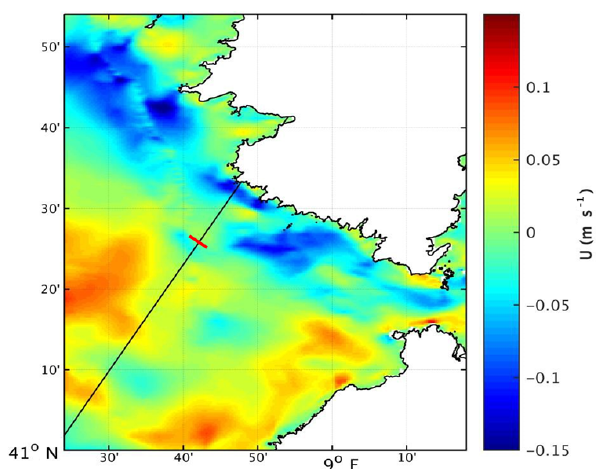
Figure 18. Barotropic current (zonal component U) for January 2014 based on the MARS3D hydrographic model. The blue color means westward current. The Jason track (black line) crosses this current at 4km from the coast. The red bar crossing the Jason track indicates the 15km distance from the coast.